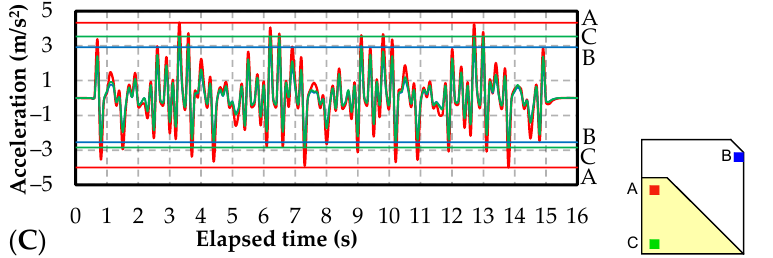
Figure 18. Variation in accelerations during earthquakes at shaking table and basement, crown of embankments subjected to rainfall ( A ) K 8.5A, ( B ) K soil, ( C ) and K 40A . The behavior of saturation degree under the post-rainfall earthquake is shown in Figure 19. As can be seen, the variation during rainfall was similar to that of the beginning of the rainfall-only experiment: sm1, sm3, and sm6 started to increase due to the infiltration of rainwater but did not yet reach their maximum value while sm2, sm4, and sm5 were almost unchanged. When cyclic loadings were applied, a general trend was observed for all three samples: sm1, sm3, and sm6 increased while sm2 and sm5 decreased. In which, the change in sm1 and sm2 was more obvious than that of sm6 and sm5. Under the effect of seismic loadings, the particles rearrange, and the pore size changes, leading to the movement of water in the pore. Through the change in the distribution of water content before and after the earthquake as shown in Figure 20, we can see that the cyclic loadings have the effect of pushing water from the inside to the outside of the model embankment. Another point worth noting for the K 40A case was the difficulty of drainage after earthquakes, which occurred not only in the basement but also in the upper parts of the slope. Thus, cyclic loadings can cause a blocking effect due to fine particle concentration at any point in the K 40A embankment.